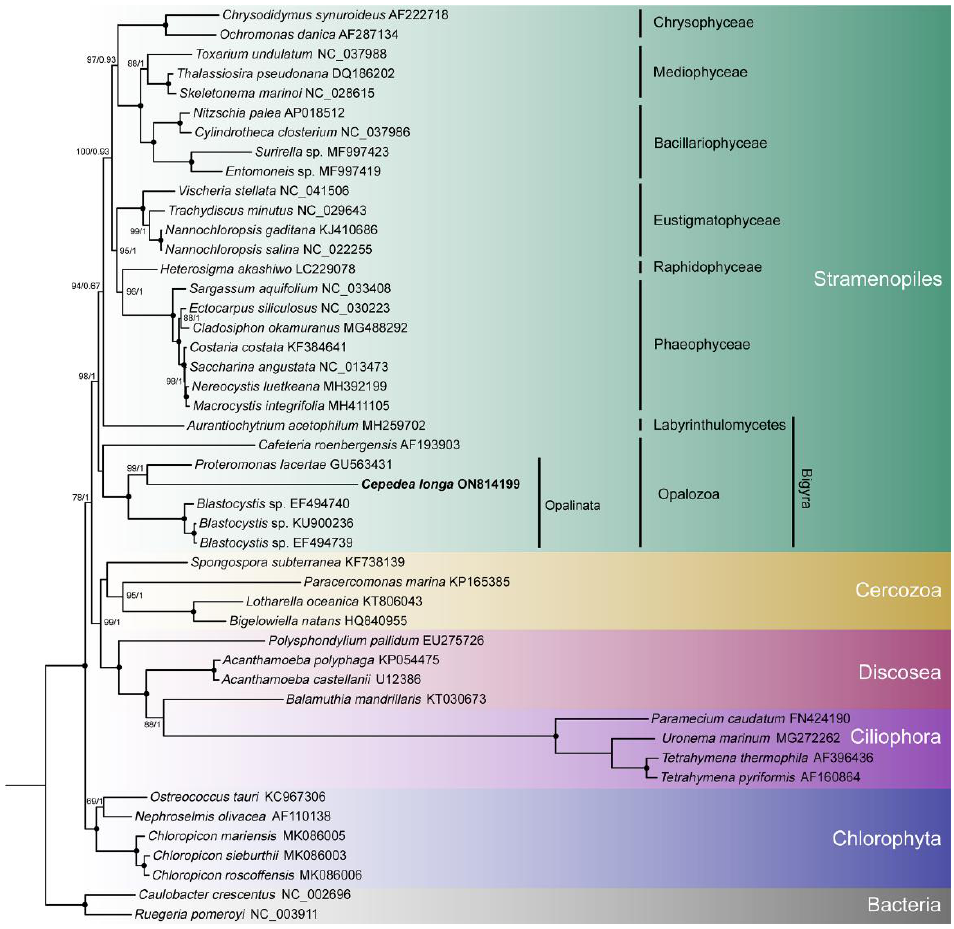
Figure 4 . Phylogenetic tree inferred using eight concatenated nad sequences. Numbers next to nodes are bootstrap values (ML) and posterior probability values (BI). Black dots represent 100% bootstrap support values and 1.00 posterior probability values. The α -proteobacteria species are set as outgroup taxa. GenBank accession numbers of sequences used in the phylogenetic analyses are listed next to the species name.